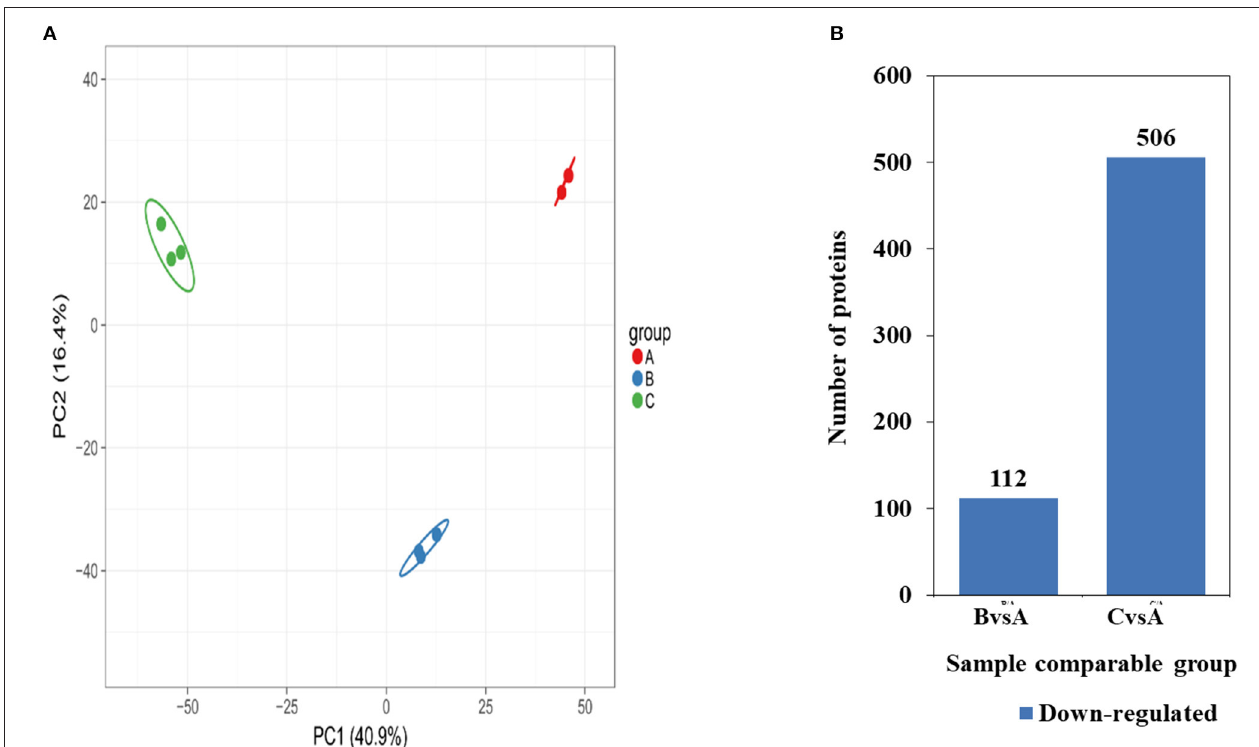
FIGURE 5 | Differentially expressed proteins identified among SBA treatments. (A) Two-dimensional scatter plot of PCA (principal component analysis) distribution of all samples using quantified protein in different treatments, (B) Up- or down-regulated proteins in different SBA treated groups. Up-regulated proteins are shown in red, down-regulated proteins are shown in blue. BvsA indicates the differential proteins enriched in 0.5 mg/mL SBA treatment when compared to control (0.0 mg/mL SBA treatment), CvsA indicates the differential proteins enriched in 2.0 mg/mL SBA treatment when compared to